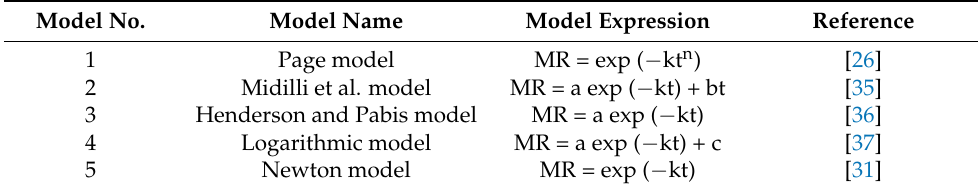
Table 1. Mathematical thin-layer drying models. Model